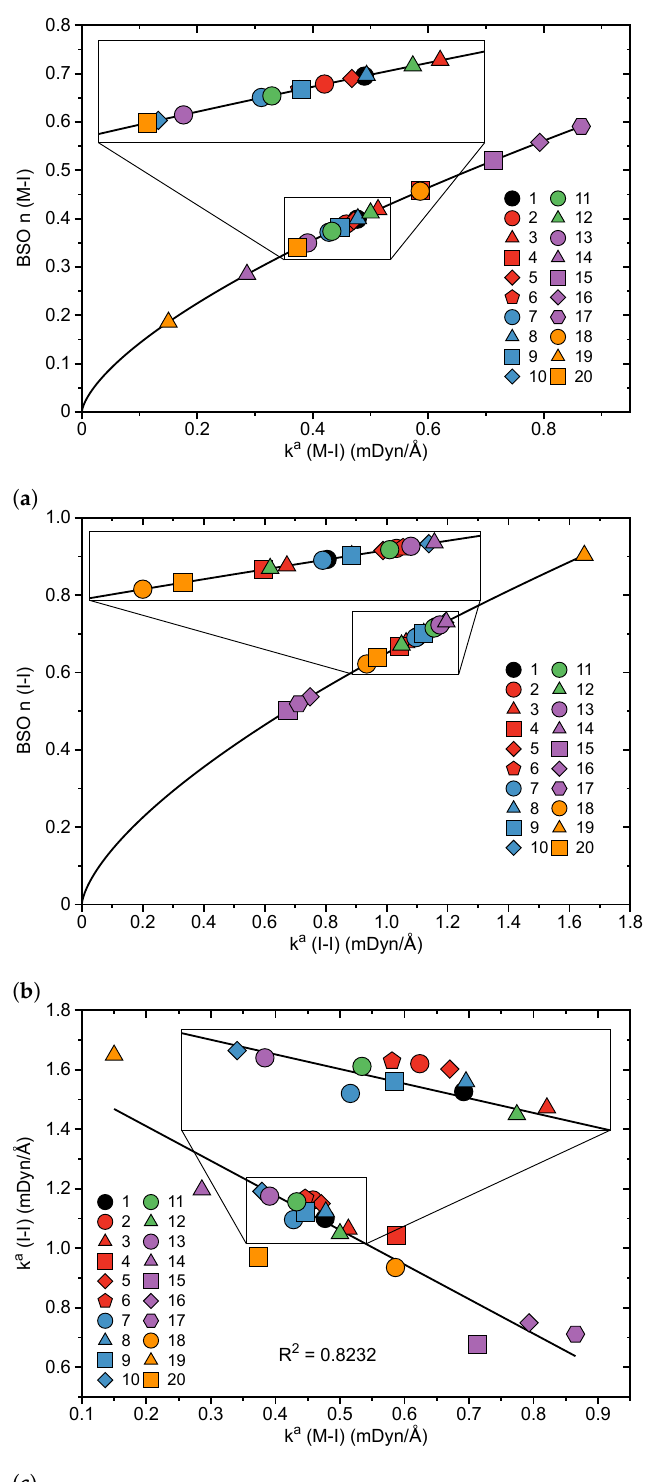
Figure 3. ( a ) Power relationship between bond strength order (BSO) n and local stretching force constant k a for the M − I bonds; ( b ) Power relationship between bond strength order (BSO) n and local stretching force constant k a for the I − I bonds; ( c ) Correlation between M − I and I − I local mode force constants k a for 1 – 20 . PBE0–D3(BJ)/aug–cc–pVTZ/PP(M,I) level of